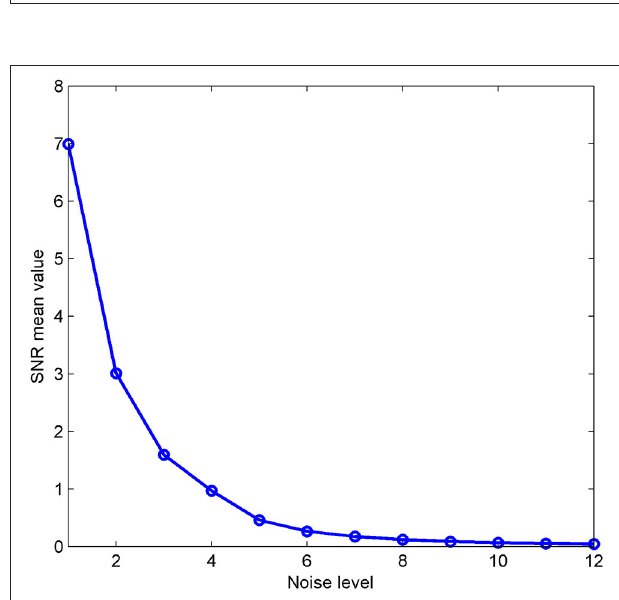
FIGURE 3 | The mean signal-to-noise ratio of the simulation is given for 12 different noise levels. Fifty noise samples were generated at each level; the x-axis represents the noise level and the y-axis represents the mean